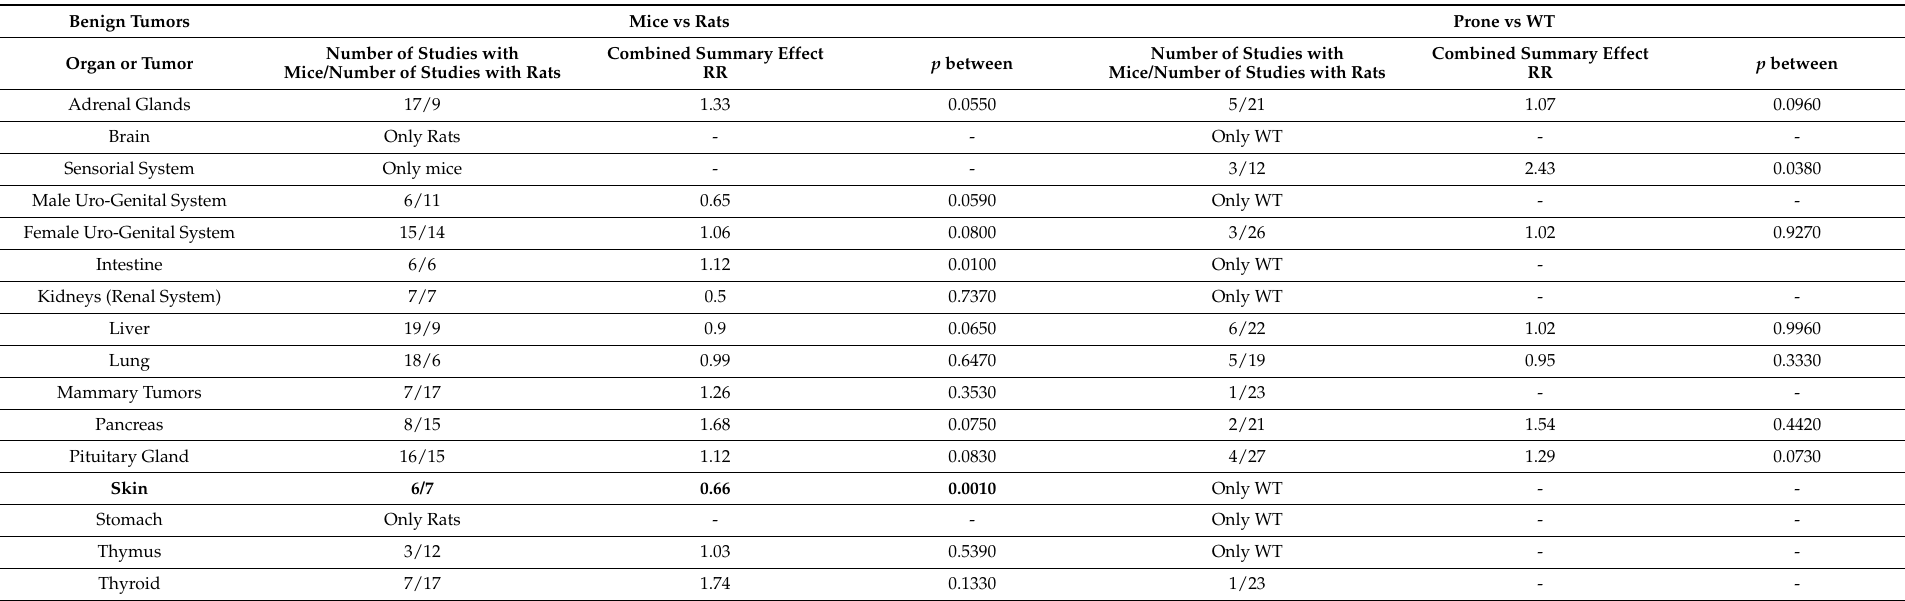
Table 7. Summary table of the subgroup analysis on benign tumors: the selected covariates for relevance are the species (mice vs. rats) and the genetic background (prone vs. WT) Bold items represent the results with statistical